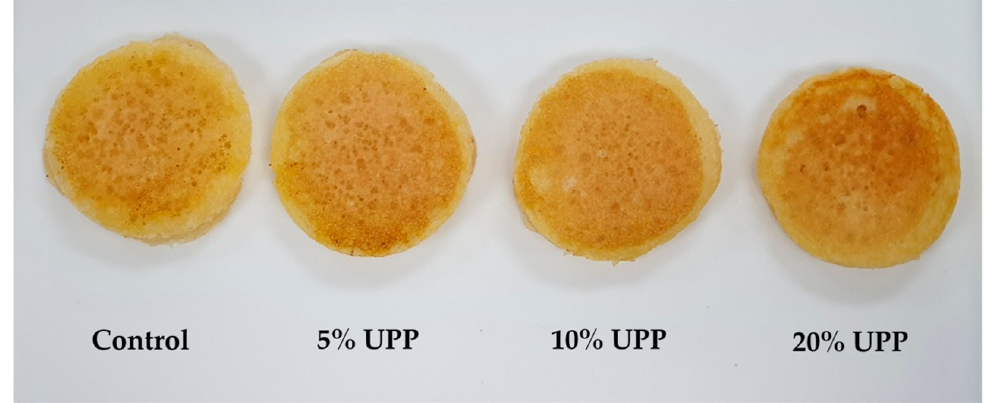
Figure 2. Photographs of unripe papaya pancake (5%–20%). Table 3. Total phenolic content and antioxidant activity of pancakes with unripe papaya powder.